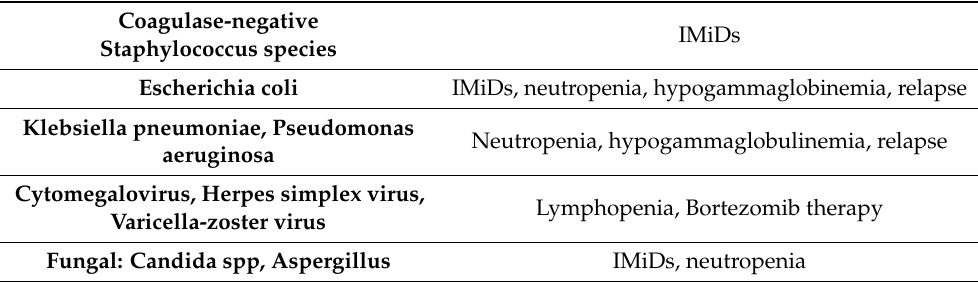
Table 3. Pathogens and Associated Risk Factors in Multiple